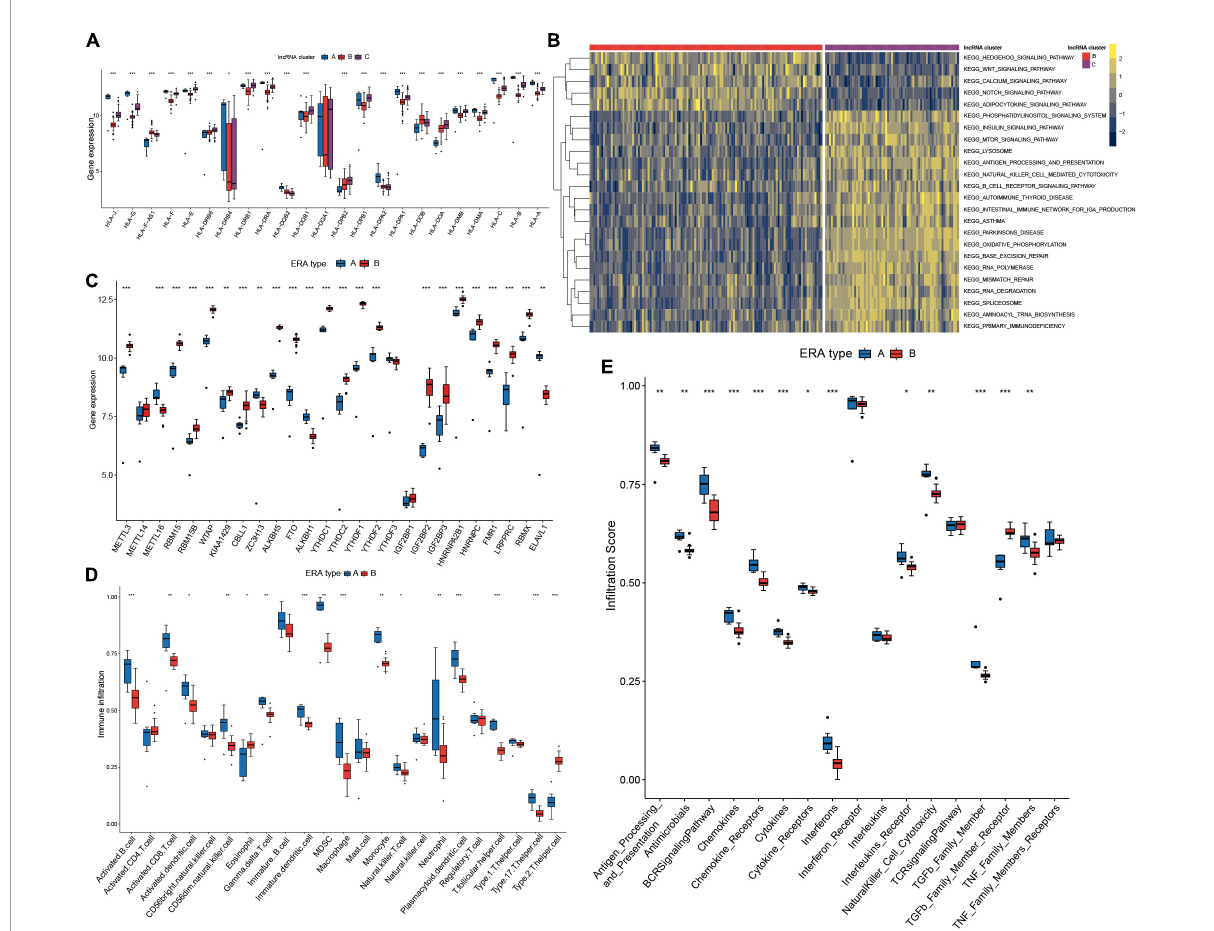
FIGURE9 Two distinct subclusters of enthesitis-related arthritis (ERA) were identified. (A) Human leukocyte antigens (HLA) gene expression varied significantly across the three long non-coding ribonucleic acid (lncRNA) clusters. (B) GSVA enrichment analysis shows the differences in the underlying biological processes between the three lncRNA clusters. (C) Different expressions of the m 6 A regulators in the two subclusters of ERA. (D) The discrepancies in the abundance of each infiltrating immunocyte in the two subclusters of ERA. (E) The two subclusters of ERA exhibit varying degrees of immunological